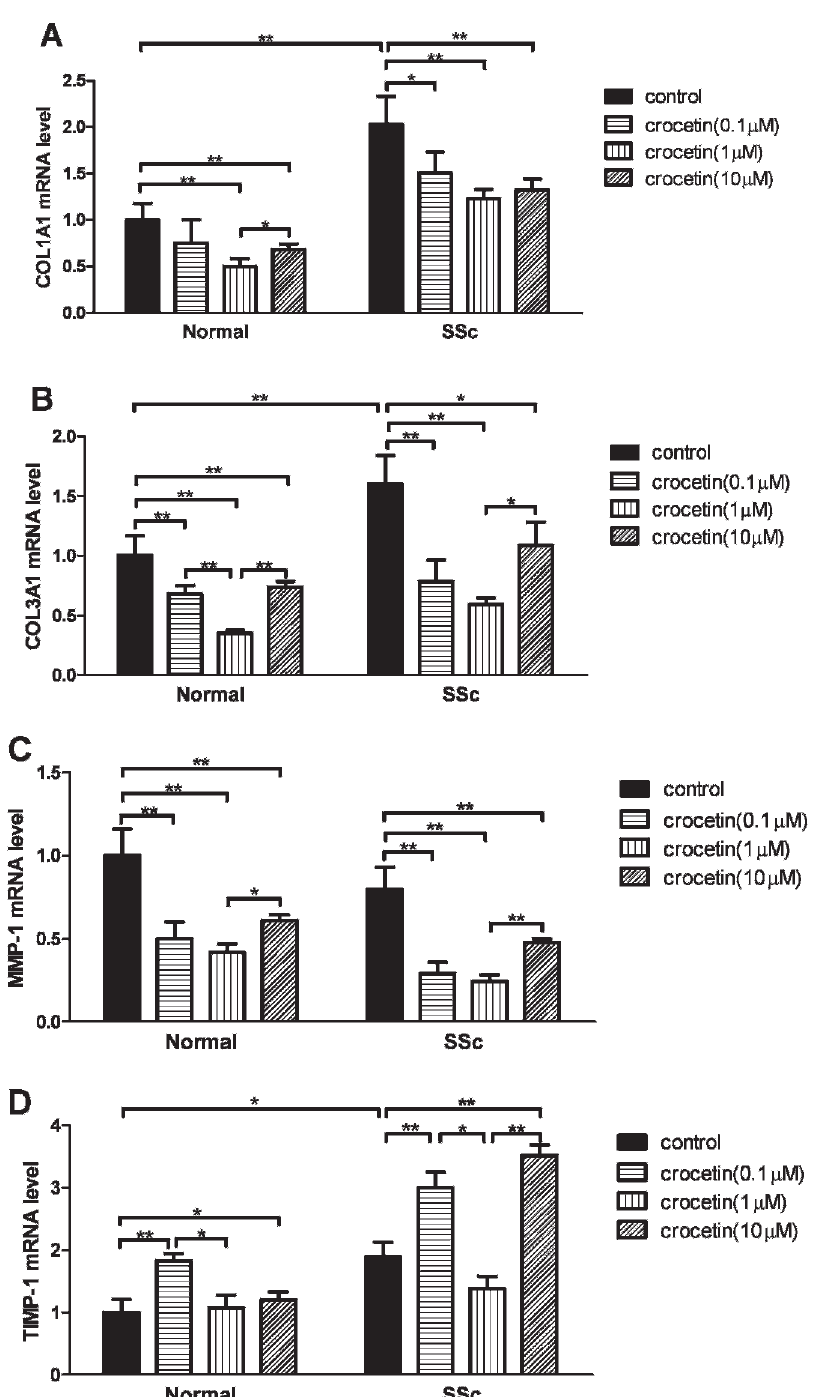
Figure 2 - Effect of crocetin on COL1A1, COL3A1, MMP-1 and TIMP-1 mRNA expression in SSc and normal fibroblasts. mRNA expression was detected using quantitative reverse transcription–polymerase chain reaction, and relative quantification was performed using the 2 - DD Ct method. The experiments were performed in triplicate and repeated twice. (A) COL1A1; (B) COL3A1; (C) MMP-1; (D) TIMP-1. * p , 0.05, ** p